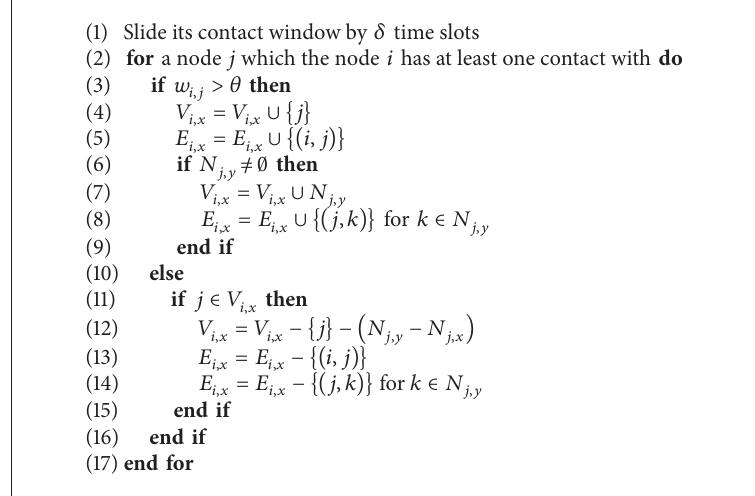
Algorithm 1: Social network construction procedure for a node 𝑖